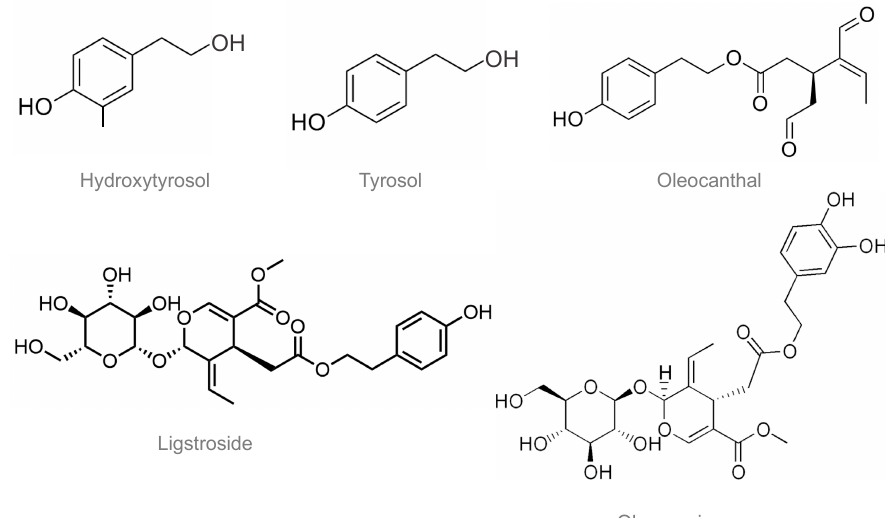
Figure 3. Representative polyphenols present in virgin olive oils.